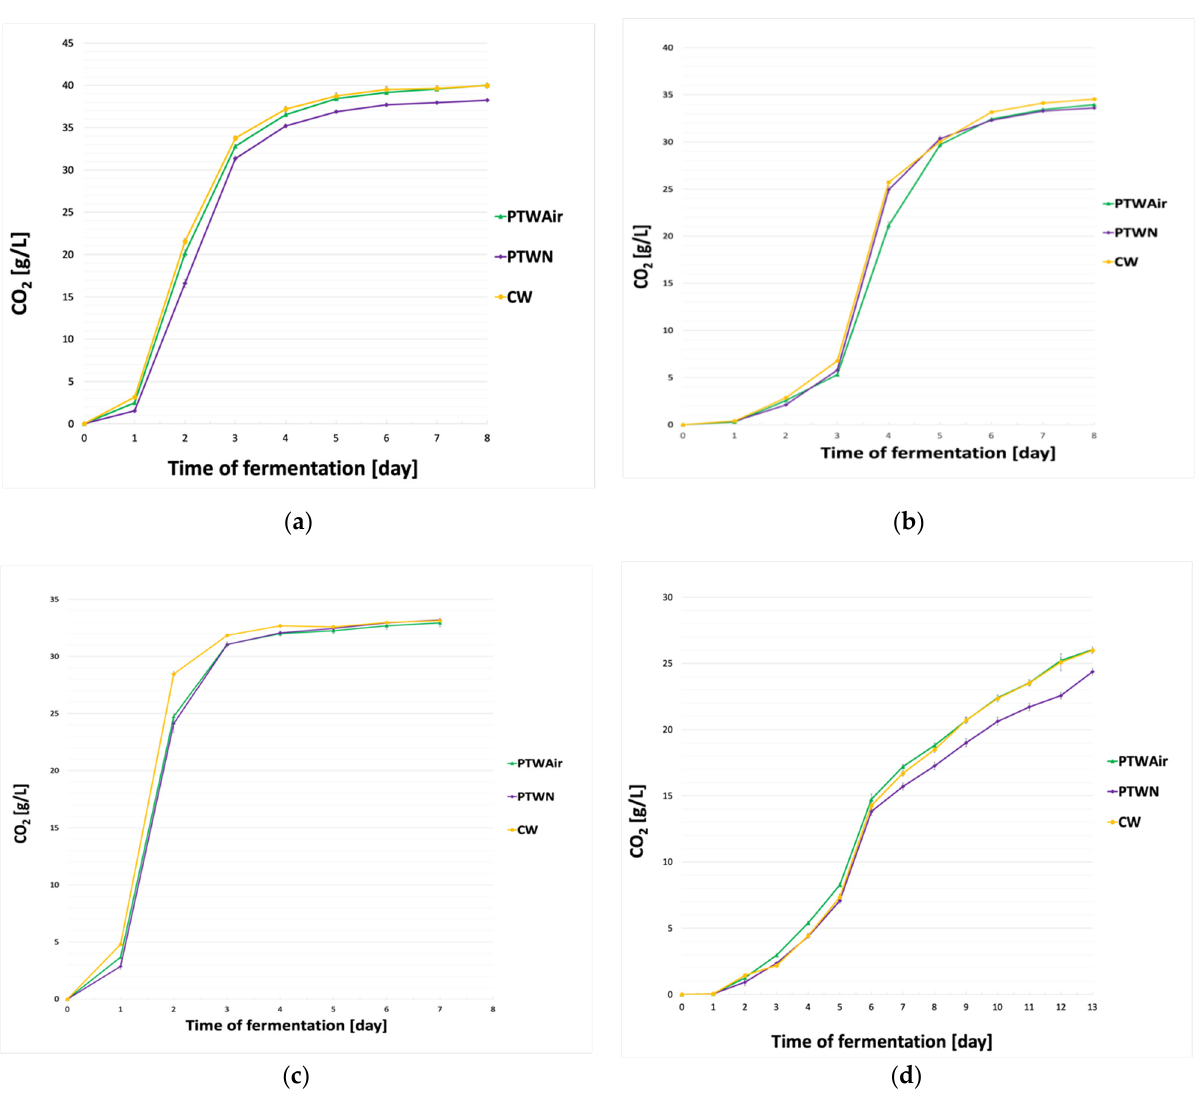
Figure 1. Fermentation kinetics of ( a ) S. cerevisiae US-05, ( b ) S. cerevisiae T58, ( c ) S. cerevisiae S33, ( d ) S. pastorianus W34/70 after rehydration with PTWAir, PTWN and CW; n = 4. During the fermentation of the wort with yeast strain Sc S33 (shown in Figure 1c), the largest differences were observed between the second and third day of the entire process, where the yeast rehydrated with plasma treated waters significantly differed from the yeast rehydrated with CW. On the remaining days, no statistically significant differences were observed in the course of the fermentation process between the samples. Fermentation with the lager yeast strain Sp W34/70 (Figure 1d) lasted for 13 days. It was observed that the yeast rehydrated with PTWAir fermented more efficiently from the 1st to the 5th day of the process. Differences were also observed from the 6th day of the fermentation process. The yeast rehydrated with PTWN showed significantly smaller weight losses compared to yeast rehydrated with PTWAir and CW. 3.2. Ethanol, Real Extract, Apparent Extract and Apparent Degree of Fermentation The alcohol content in the analyzed beers fermented by S. cerevisiae strains ranged from 4.30% to 5.35% (v/v), while by S. pastorianus—from 4.51% to 4.79% (v/v) (Table 2). In the obtained results, we noticed that different medium used for yeast rehydration sig- nifi-cantly contributed the alcohol content in all of the analyzed beers. The sample of Sc US-05 strain was characterized by the highest alcohol content, compared to other strains, respec-tively, 5.26% to 5.35% v/v. The lowest alcohol amount was found in the samples ferment-ed by the yeast strain Sc S33 (4.30% to 4.48% v/v). A similar trend was observed in the case of the Sc T58 and Sp W34/70 strains. In both cases, rehydration in the presence of PTWN contributed to a significant reduction in alcohol content when compared to CW.